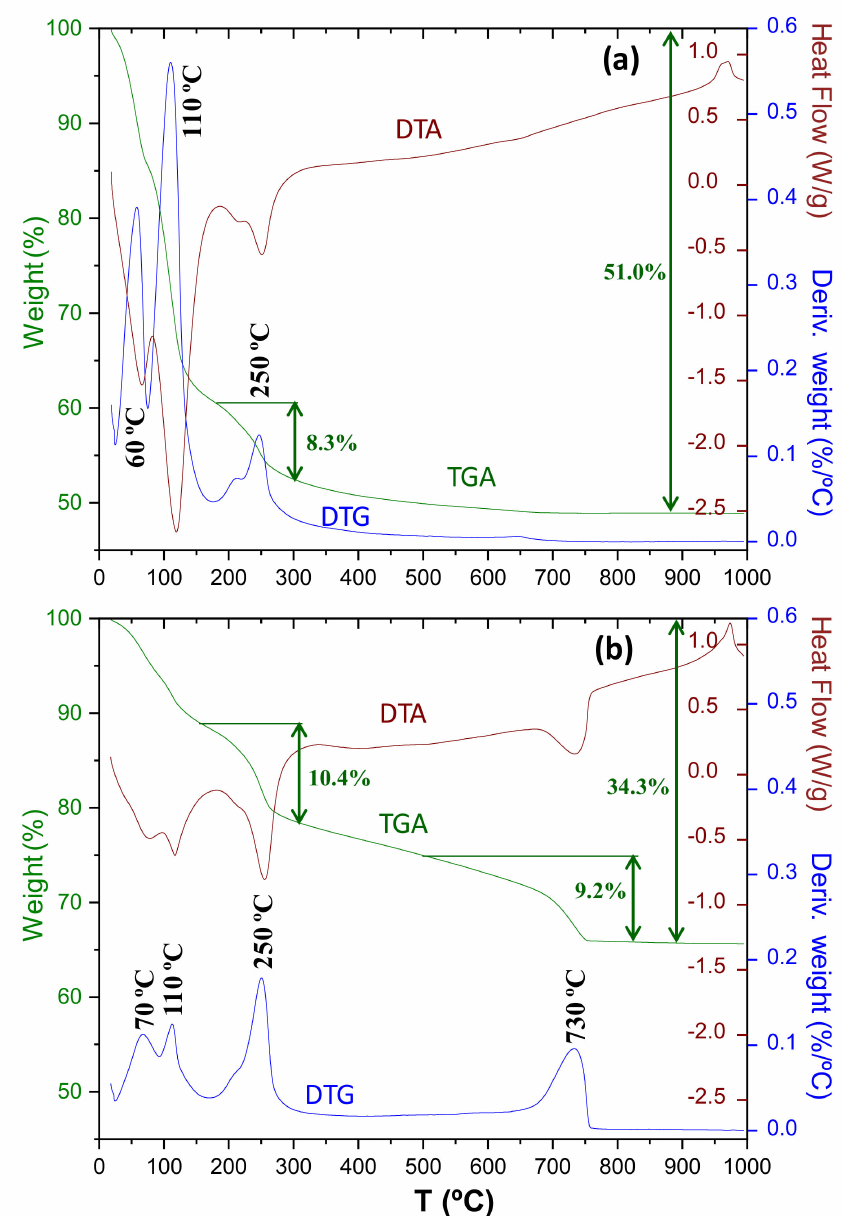
Figure 9. Thermal analysis traces (green: weight losses, blue: derivative of the weight losses and brown: heat flow) for ( a ) Y-A_hyd, and ( b ) Y-A_carb. For Y-A_hyd, the reported weight losses 8.3 and 51.0% were calculated from the temperature ranges 175–300 and RT–900 ◦ C, respectively. For Y-A_carb, the reported weight losses 10.4, 9.2 and 34.3% were calculated from the